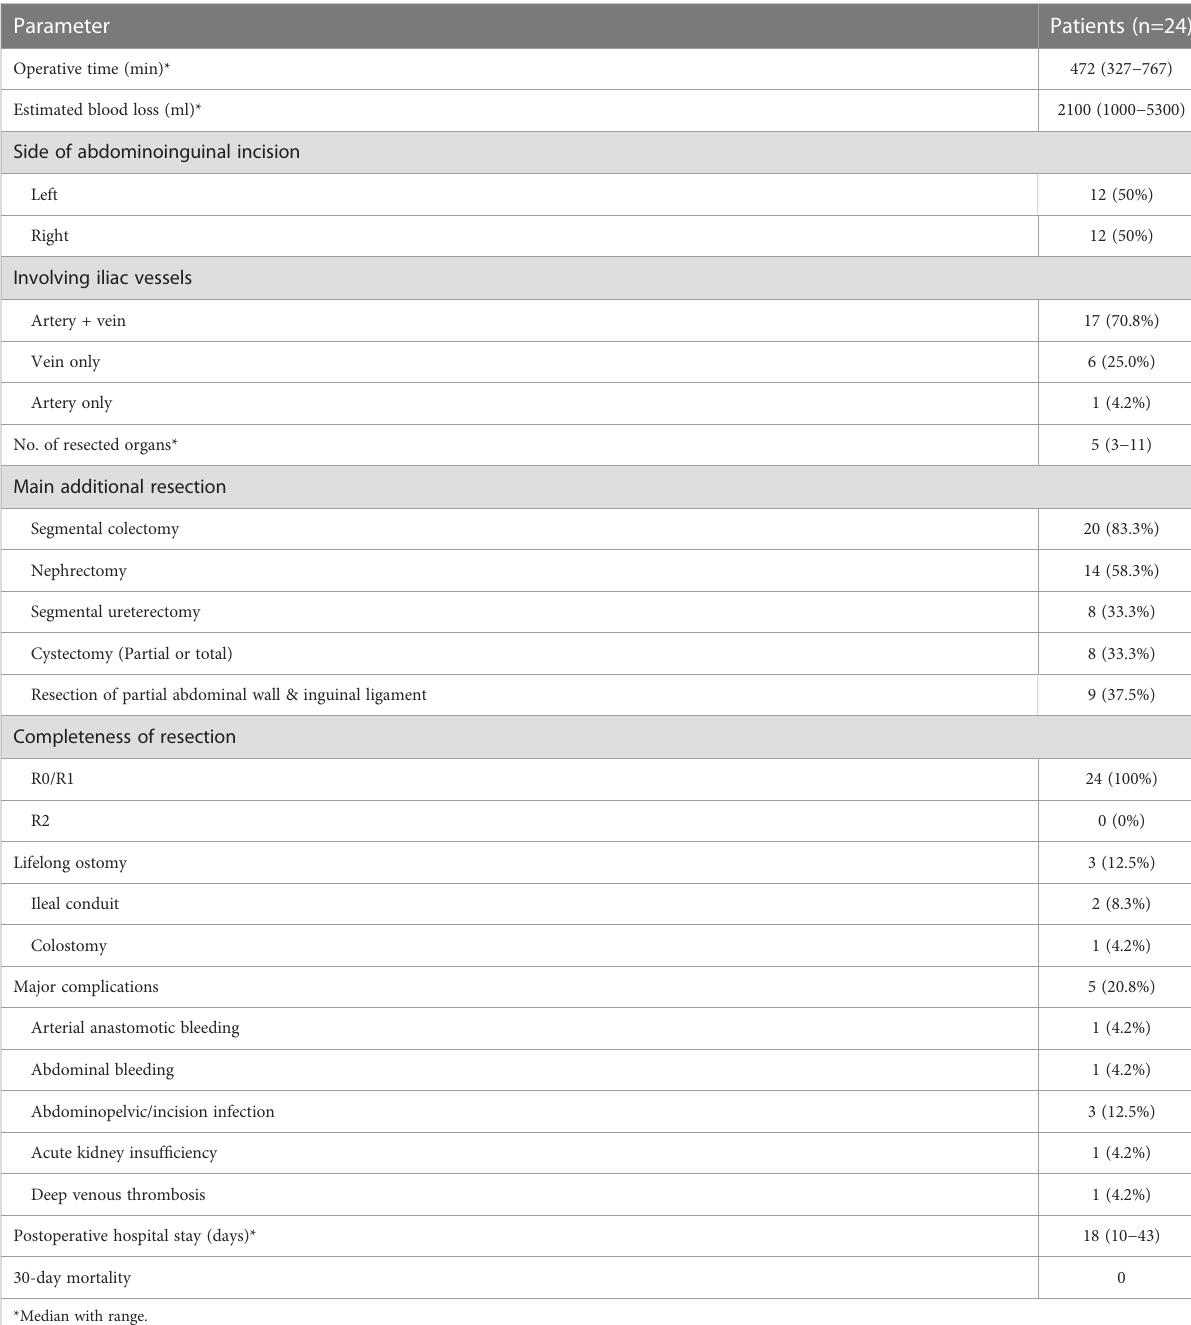
TABLE 2 Operative characteristics and postoperative complications of